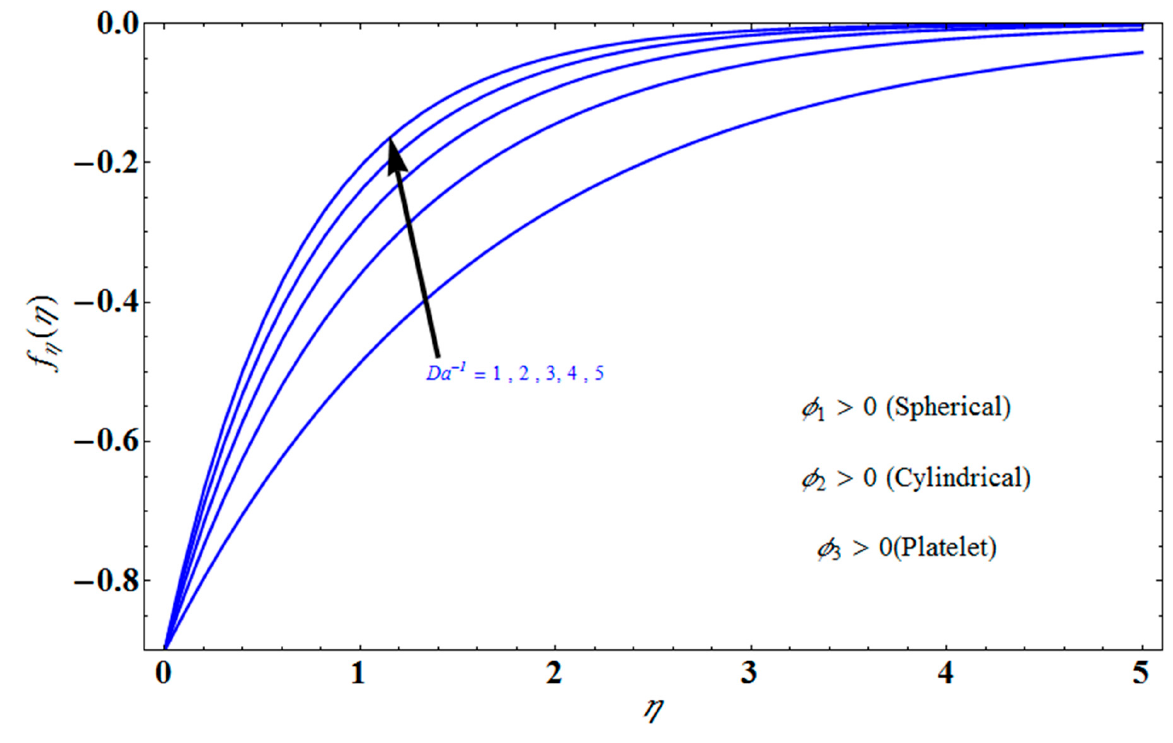
( ) η η f on for different values of η